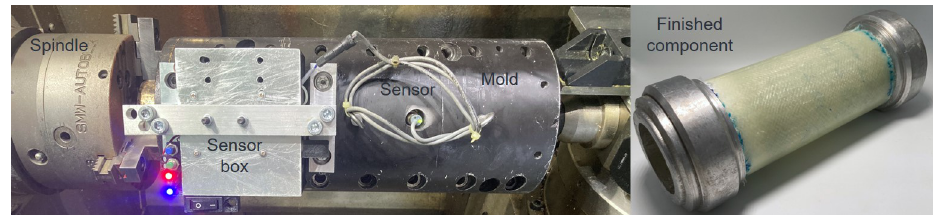
Figure 10. Mold for the rotational molding process and finished